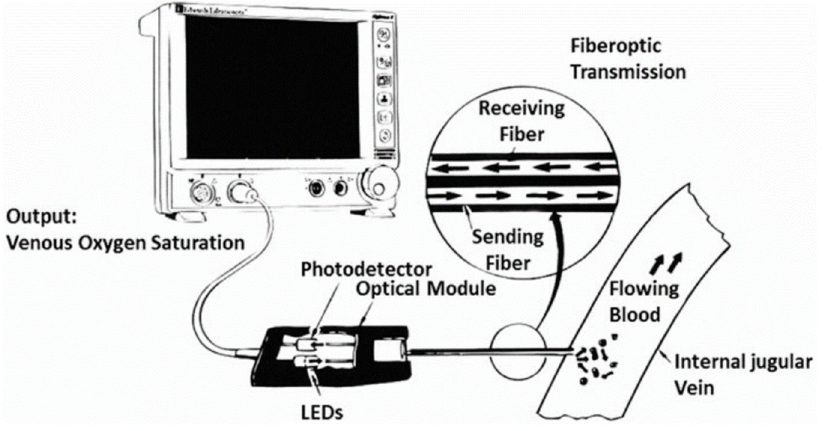
Figure 2. Working principle of the SjvO 2 monitoring equipment [18].